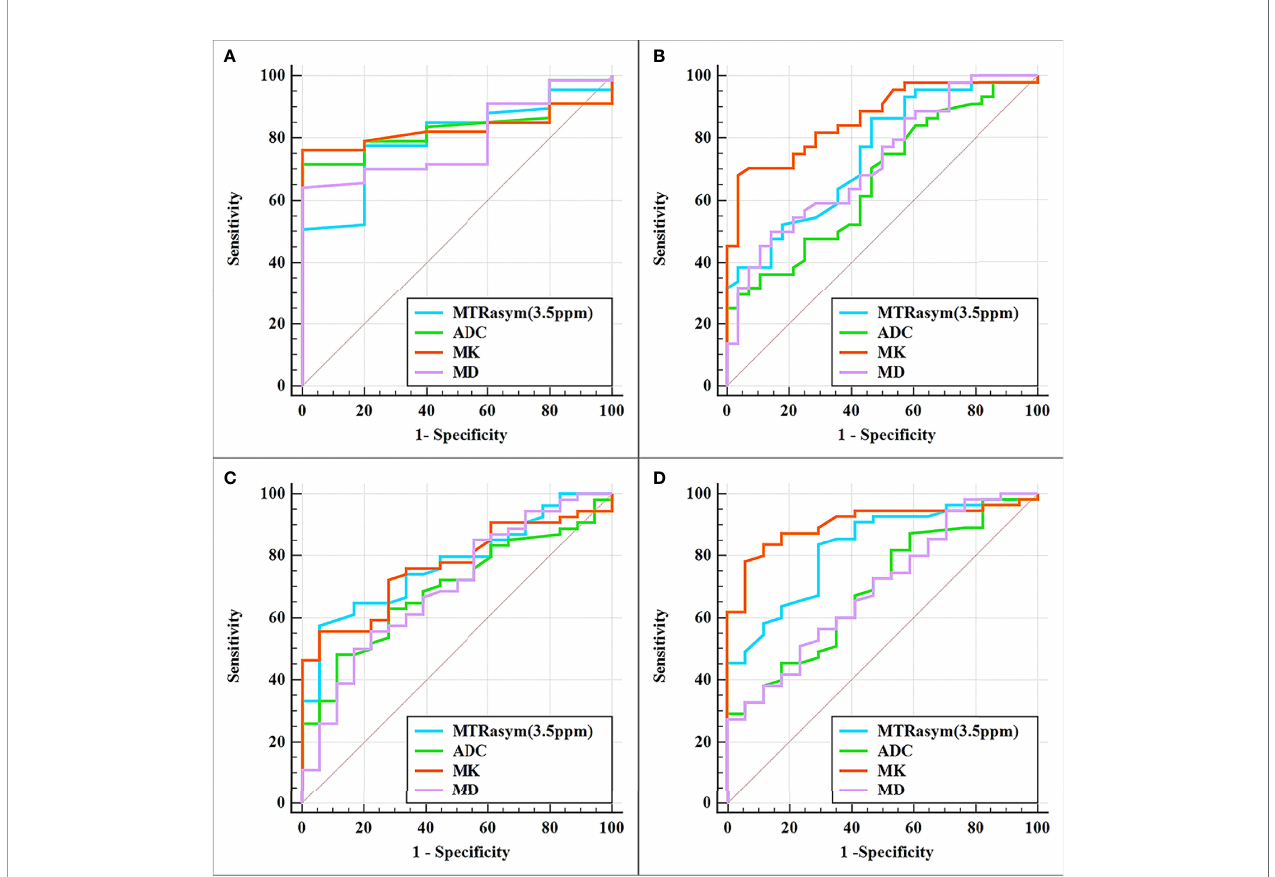
FIGURE 3 | Curves showing each parameter using receiver operating characteristic (ROC) analysis for the differentiation of adenocarcinoma and non- adenocarcinoma (A) , stage IA and stage IB (B) , LVSI-positive and LVSI-negative (C) , and high-grade and non-high-grade (D) stage I endometrial cancer (EC). Details of the area under the curves and the 95% CIs of each index are shown in Table 5